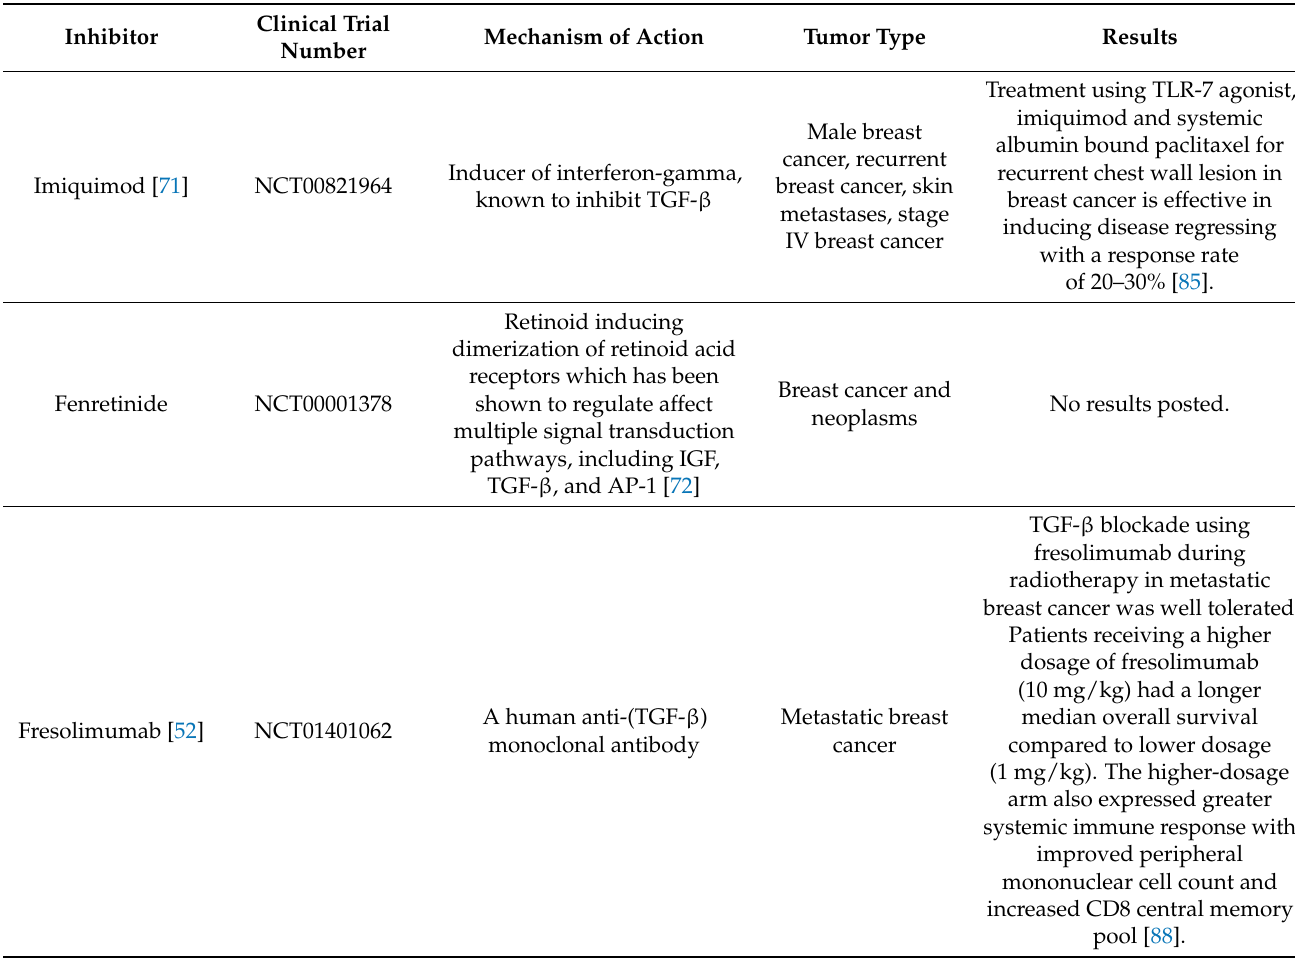
TGF- β Inhibitors in Completed Breast Cancer Clinical